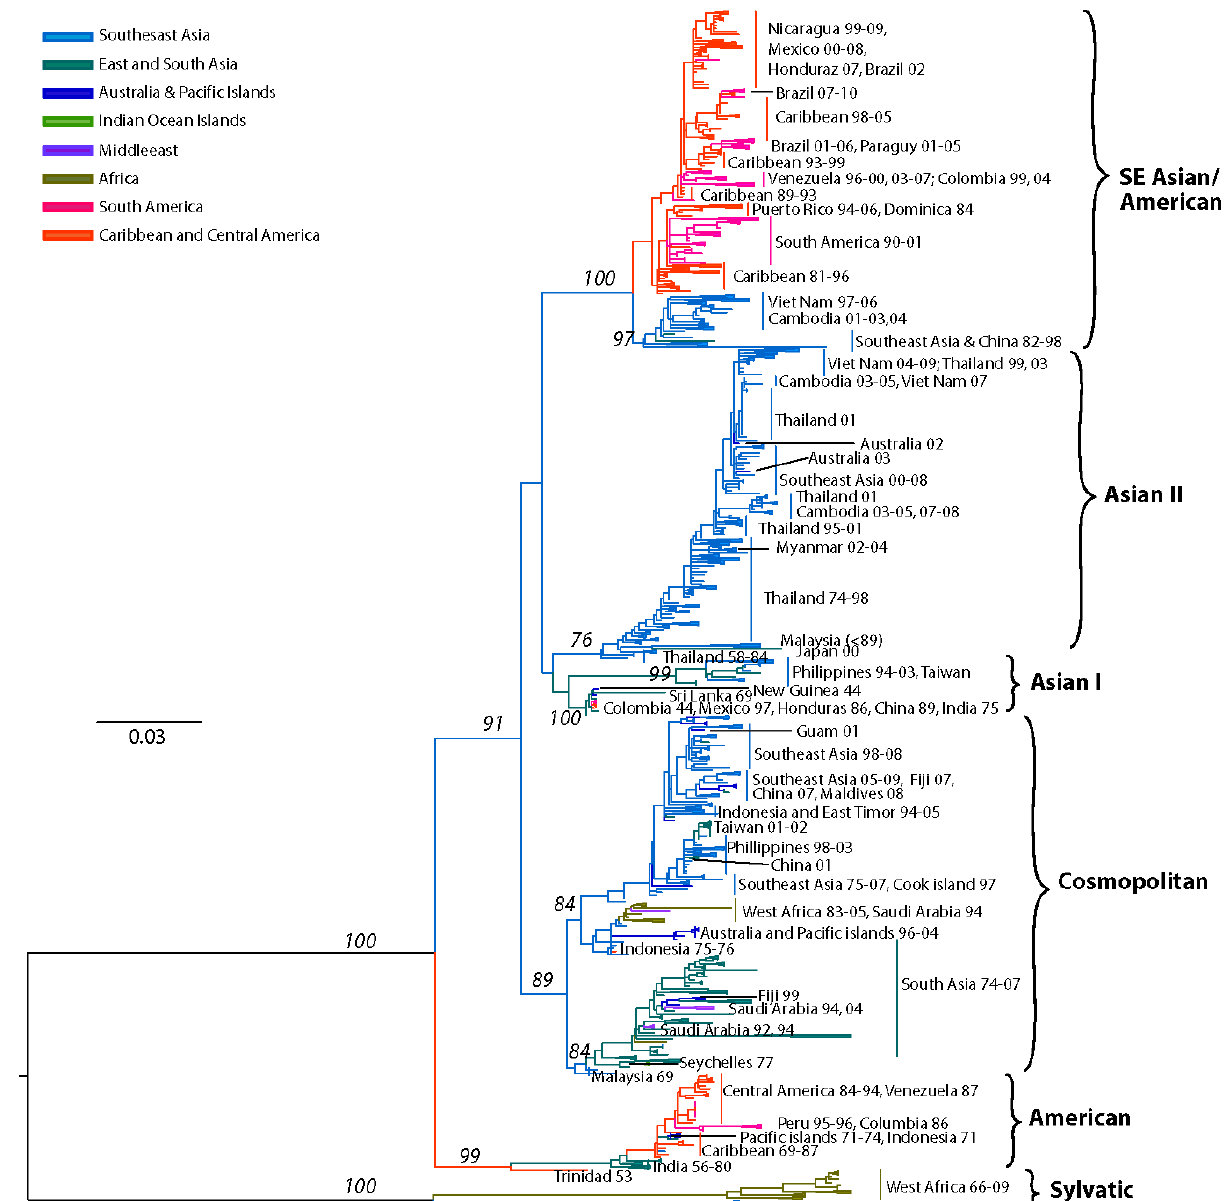
Figure 3. Dengue Virus Type 2 Phylogeny. Maximum Likelihood Tree (MLT) of